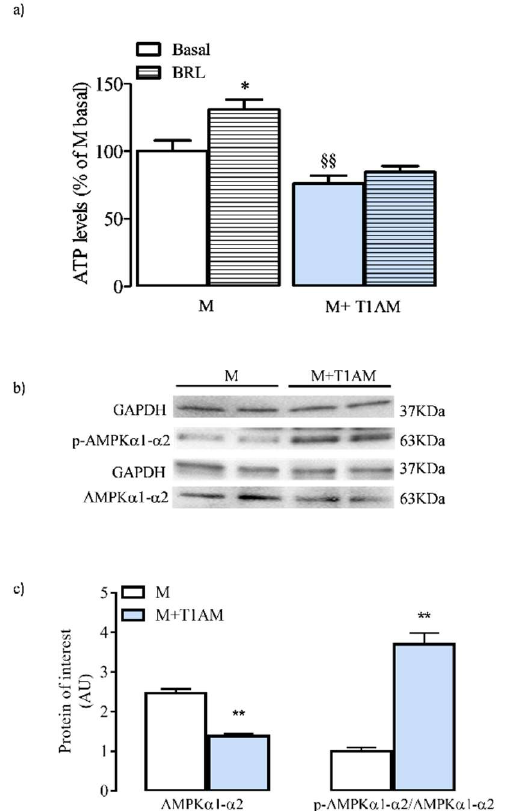
Figure 6. ATP and p-AMPK cell levels in M and M+T1AM cells. M and M+T1AM cells were analyzed for ATP content and p-AKT/AKT expression as described in the Materials and Methods. Panel ( a ) shows ATP cellular content in M and M+T1AM cells at basal conditions and after 3 h incubation with 0.1 μM BRL37344 (BRL; * p < 0.05, §§ p < 0.001 vs. basal). Western blot analysis of p-AKT/AKT in M and M+T1AM cells is reported as arbitrary units (AU); see the Methods. A representative experiment is shown The gel was loaded with proteins derived from two different cell preparations ( b ) The histogram in Panel ( c ) represents the mean ± standard error of the mean (SEM; n = 4 cell preparations) of AU (see the Methods; * p < 0.05, ** p < 0.01, §§ p < 0.001 vs. basal).